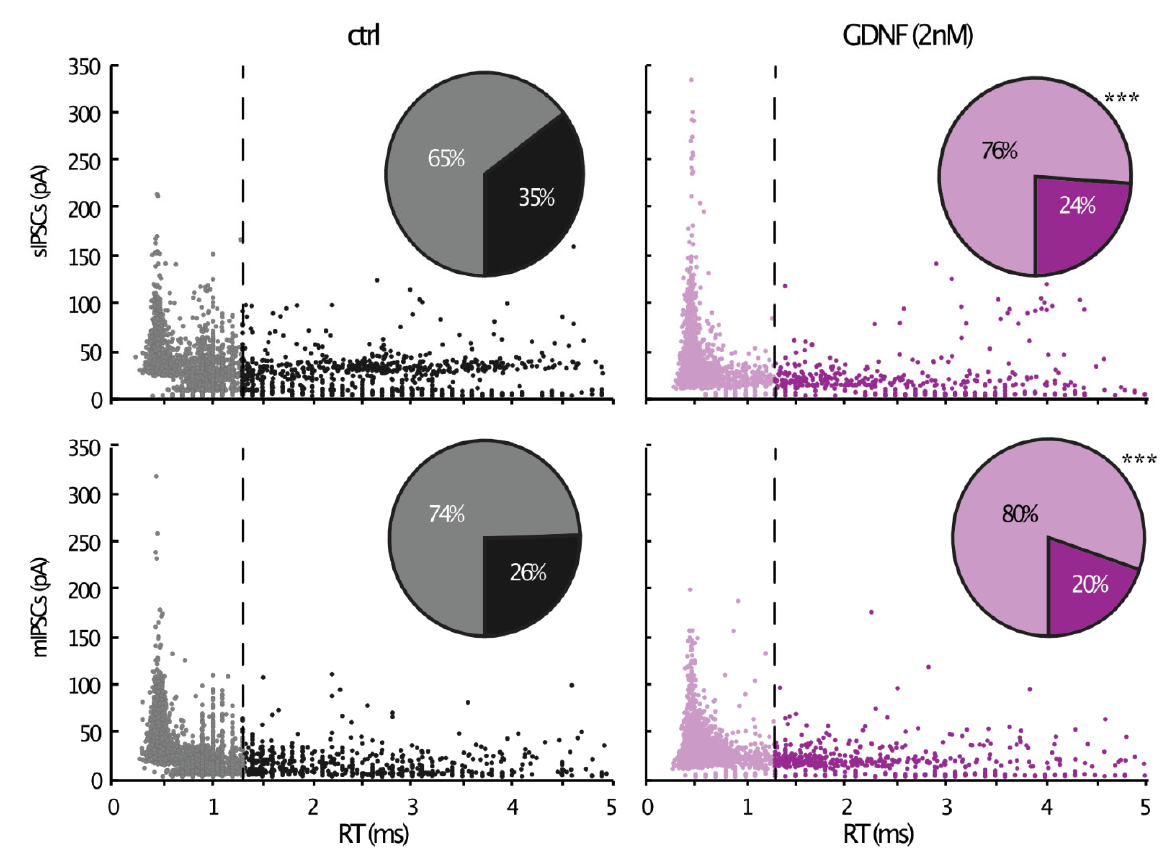
Figure 2. Bivariate plot of amplitude and rise time for each event. The pie charts depict the percentage of fast and slow events. ***: Fisher’s exact test p < 0.001.